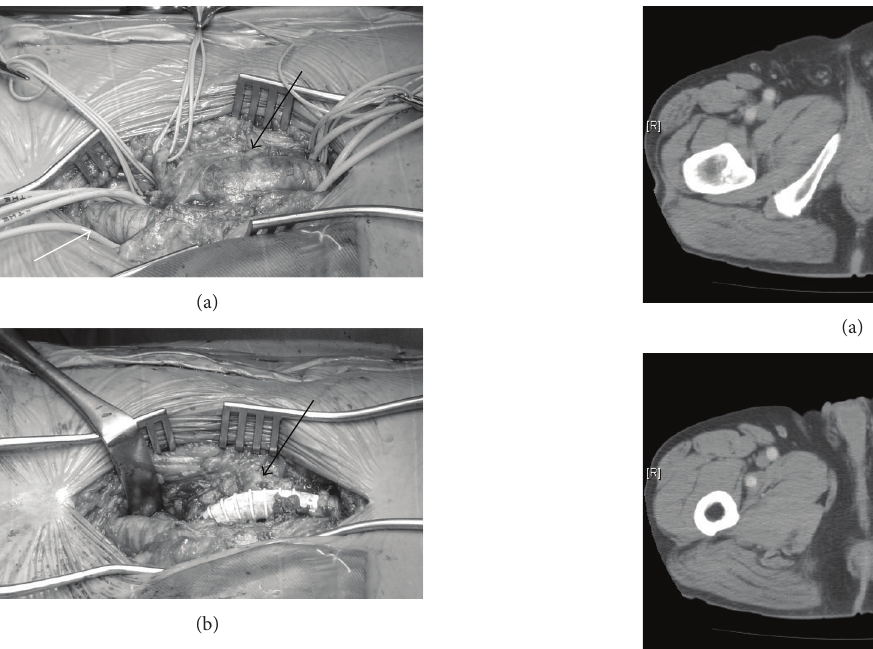
Figure 3: (a) The intraoperative findings showed the controlled profunda femoris artery (black arrow) and superficial femoral artery (white arrow), and (b) the aneurysmectomy was performed with graft interposition (black arrow). The patient’s head was to the right.